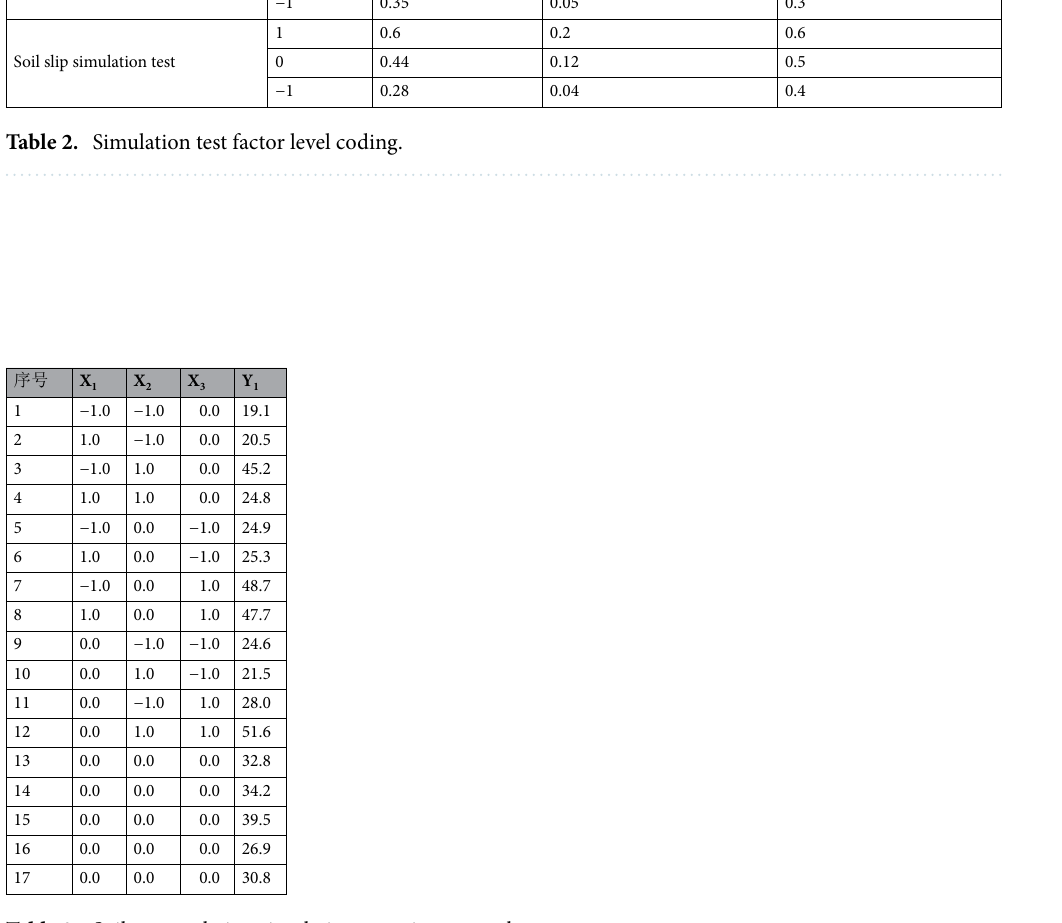
Table 3. Soil accumulation simulation experiment